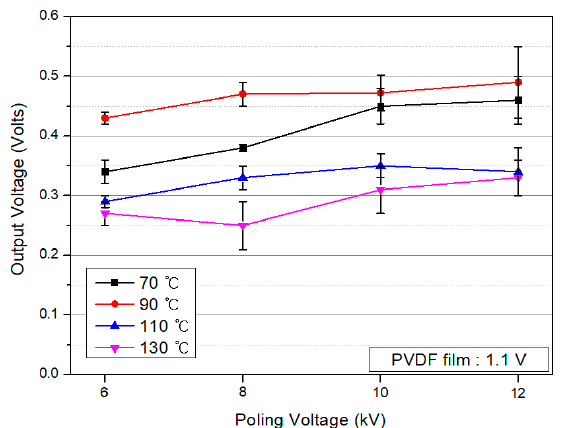
Figure 14. Output voltages of the PVDF/PAR composites as conditions of poling voltage under a pressure of 30 N.